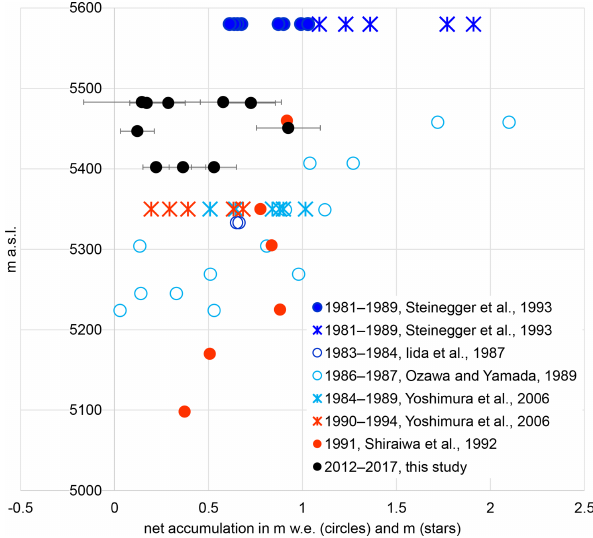
Figure 14. Positive point mass balances in the accumulation area from mass-balance years in the 1980s (blue), 1990s (red) and from this study (black). The data were compiled from annual snow-pit measurements, multiannual snow profiles, ice cores, and crevasses, using dirt, algae or ice layers to distinguish annual layers. Most measurements were converted into water equivalents (circles), and some are only available as snow depth